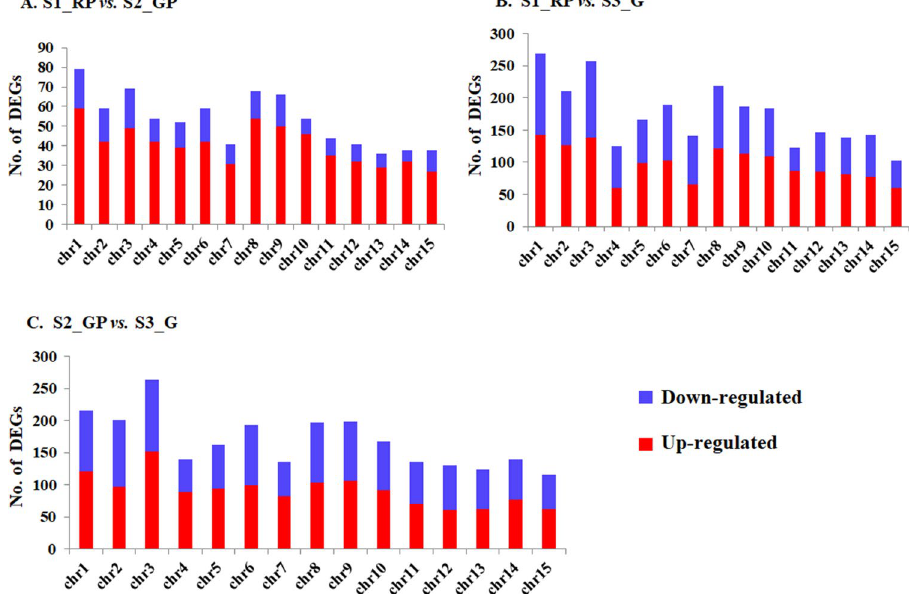
Figure 3. Differentially expressed genes identified by pairwise comparison and their chromosomal distribution in the CSS genome. Red and blue bars represent up-regulated and down-regulated DEGs,